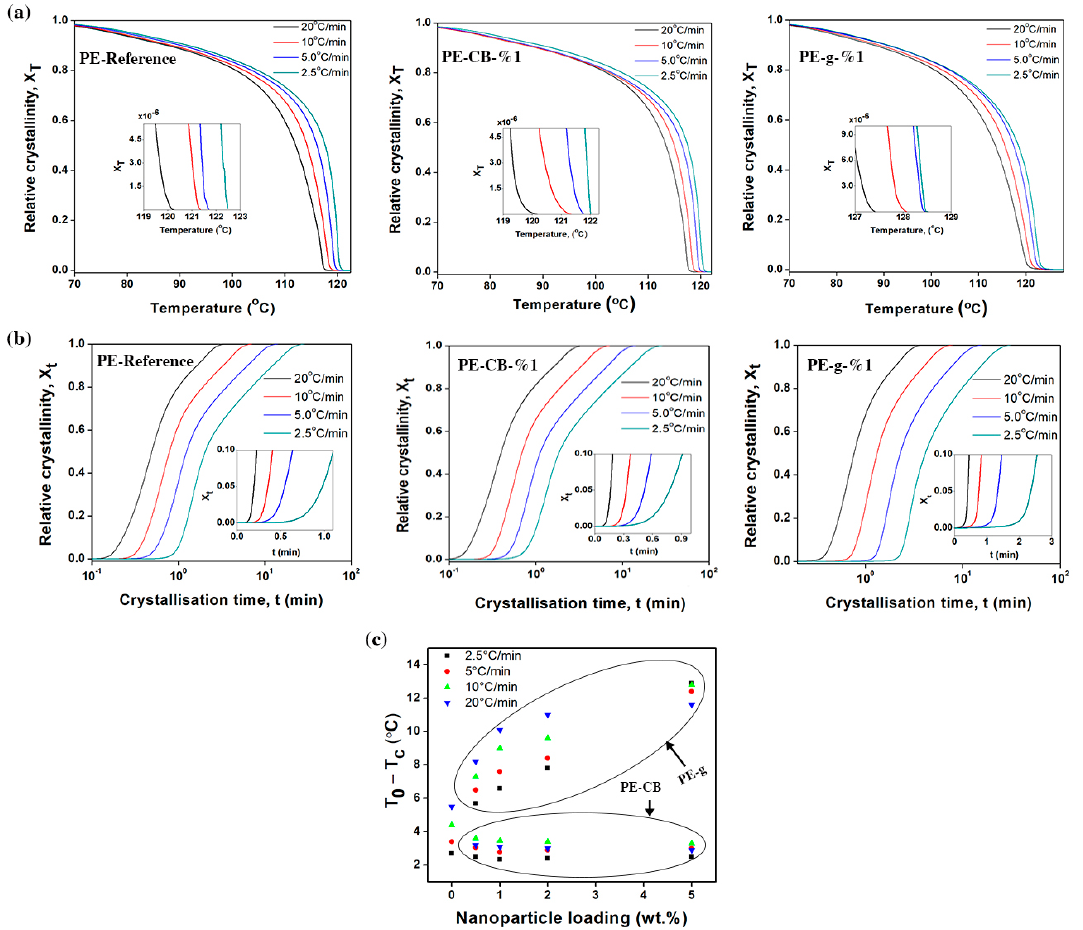
Figure 4. The effect of carbon black and graphene on non-isothermal crystallisation kinetics of the multimodal-HDPE. ( a ) Relative crystallinity evolution as a function of crystallisation temperature ( X T ) for the neat multimodal-HDPE, PE-CB-1% and PE-g-1%, occurred under non-isothermal conditions. The onset temperature of crystallisation at different cooling rates are presented in the inset. ( b ) Relative crystallinity evolution as a function of crystallisation time ( X t ) for the neat multimodal-HDPE, PE-CB-1% and PE-g-1%, occurred under non-isothermal conditions. The incubation period at different cooling rates are shown in the inset. ( c ) Effect of carbon black and graphene on ( T 0 − T c ) of the multimodal-HDPE at different cooling rates.